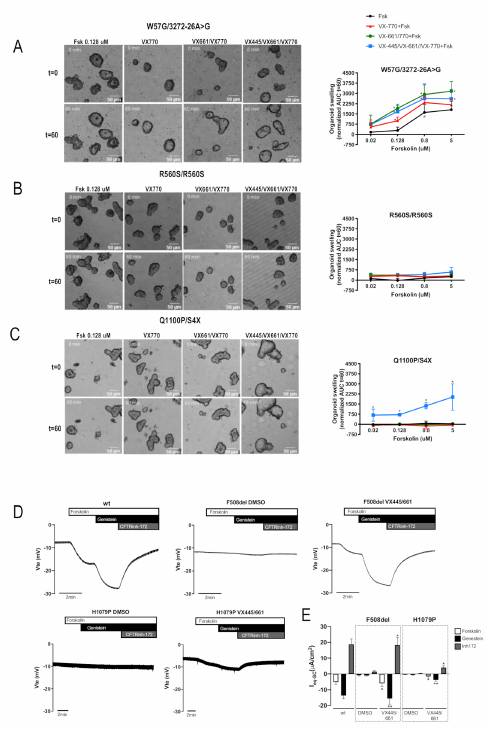
Figure 2. Analysis of W57G, R560S, H1079P and Q1100P effect in CFTR activity. FIS assay showing the CFTR response to treatment with VX-661 and VX-445 in intestinal organoids bearing the muta- tions W57G ( A ), R560S ( B ) and Q1100P ( C ). Asterisks indicate significant difference compared with Fsk ( p -value < 0.05, ANOVA). Cardinals indicate significant difference compared with 0.02 µ M Fsk ( p -value < 0.05, ANOVA). ( D ) Original Ussing chamber (open-circuit) recordings showing transep- ithelial voltage measurements (Vte) obtained from CFBE cells expressing wt-, F508del- and H1079P- CFTR. ( E ) Graph summarizing equivalent short-circuit currents (I eq-sc ) after simulation with forskolin (0.128 µ M) obtained in D. A low Cl - Ringer solution was used at apical side to stablish a Cl - gradient. Asterisks indicate significant difference compared with DMSO (* p -value < 0.05, ** p -value < 0.01, unpaired t